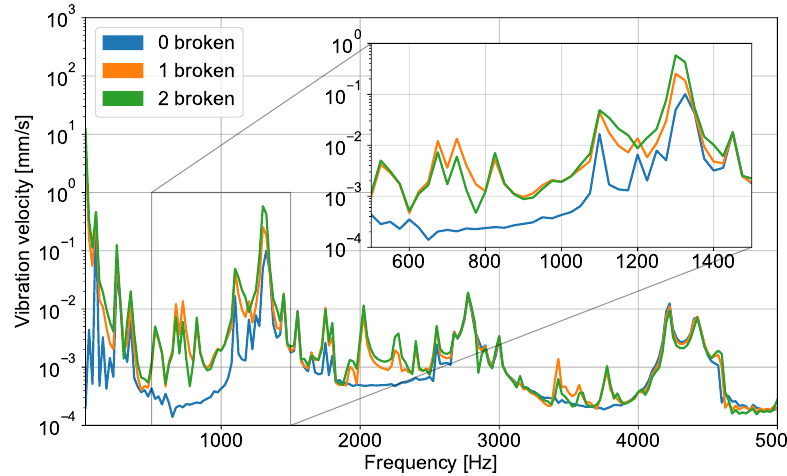
Figure 4. A vibration spectrum of a machine with BRBs and healthy rotor bars.